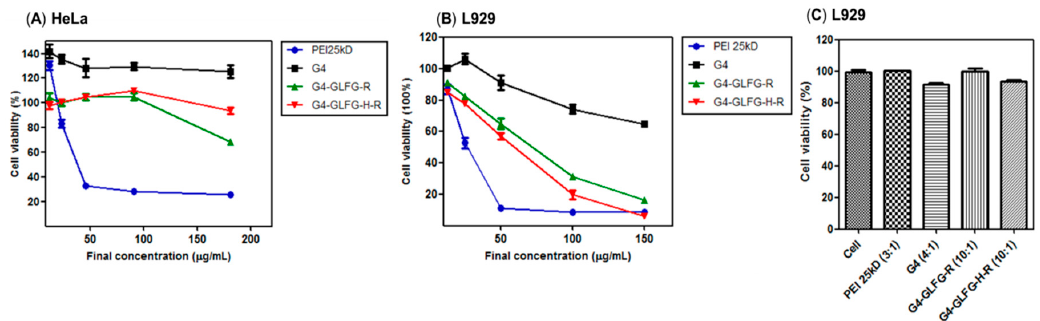
Figure 8. MTT (3-(4,5-dimethylthiazol-2-yl)-2,5-diphenyltetrazolium bromide) assay in HeLa and L929 cells. ( A , B ) Cytotoxicity test depending on polymer concentration; ( C ) cytotoxicity test of polyplex in L929, polymer:pDNA, w / w . Data are shown as mean ± standard deviation ( n = 3).